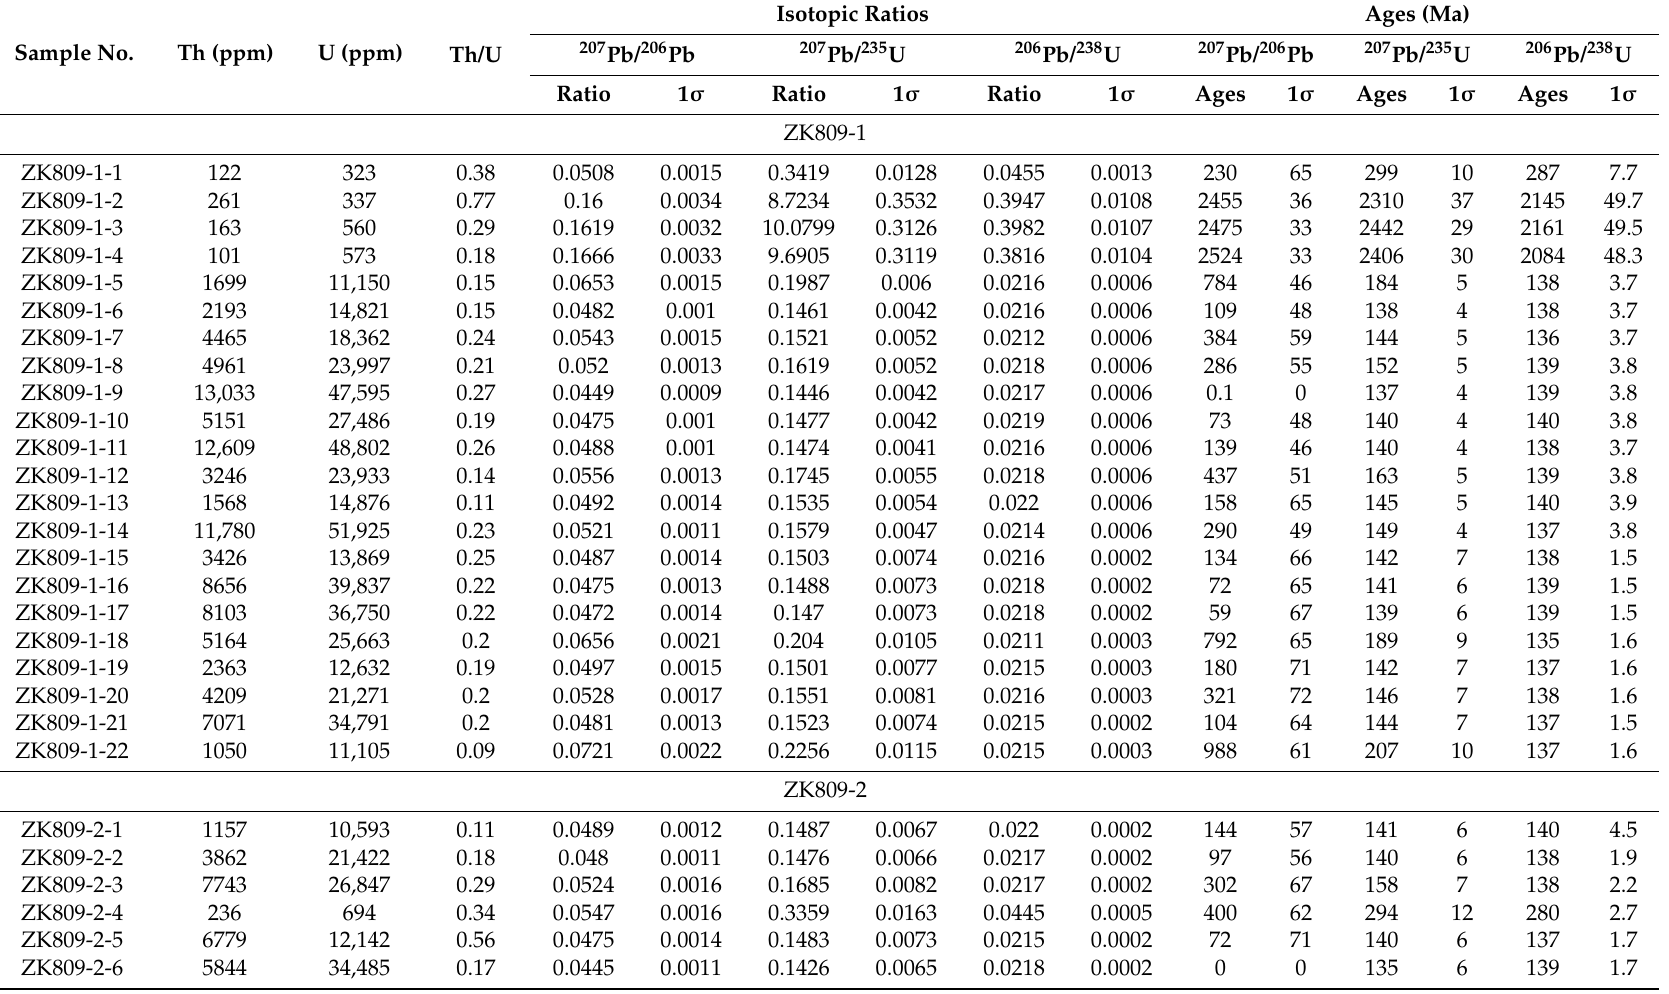
Table 1. LA-ICP-MS zircon U-Pb dating data of quartz porphyry of Weilasituo